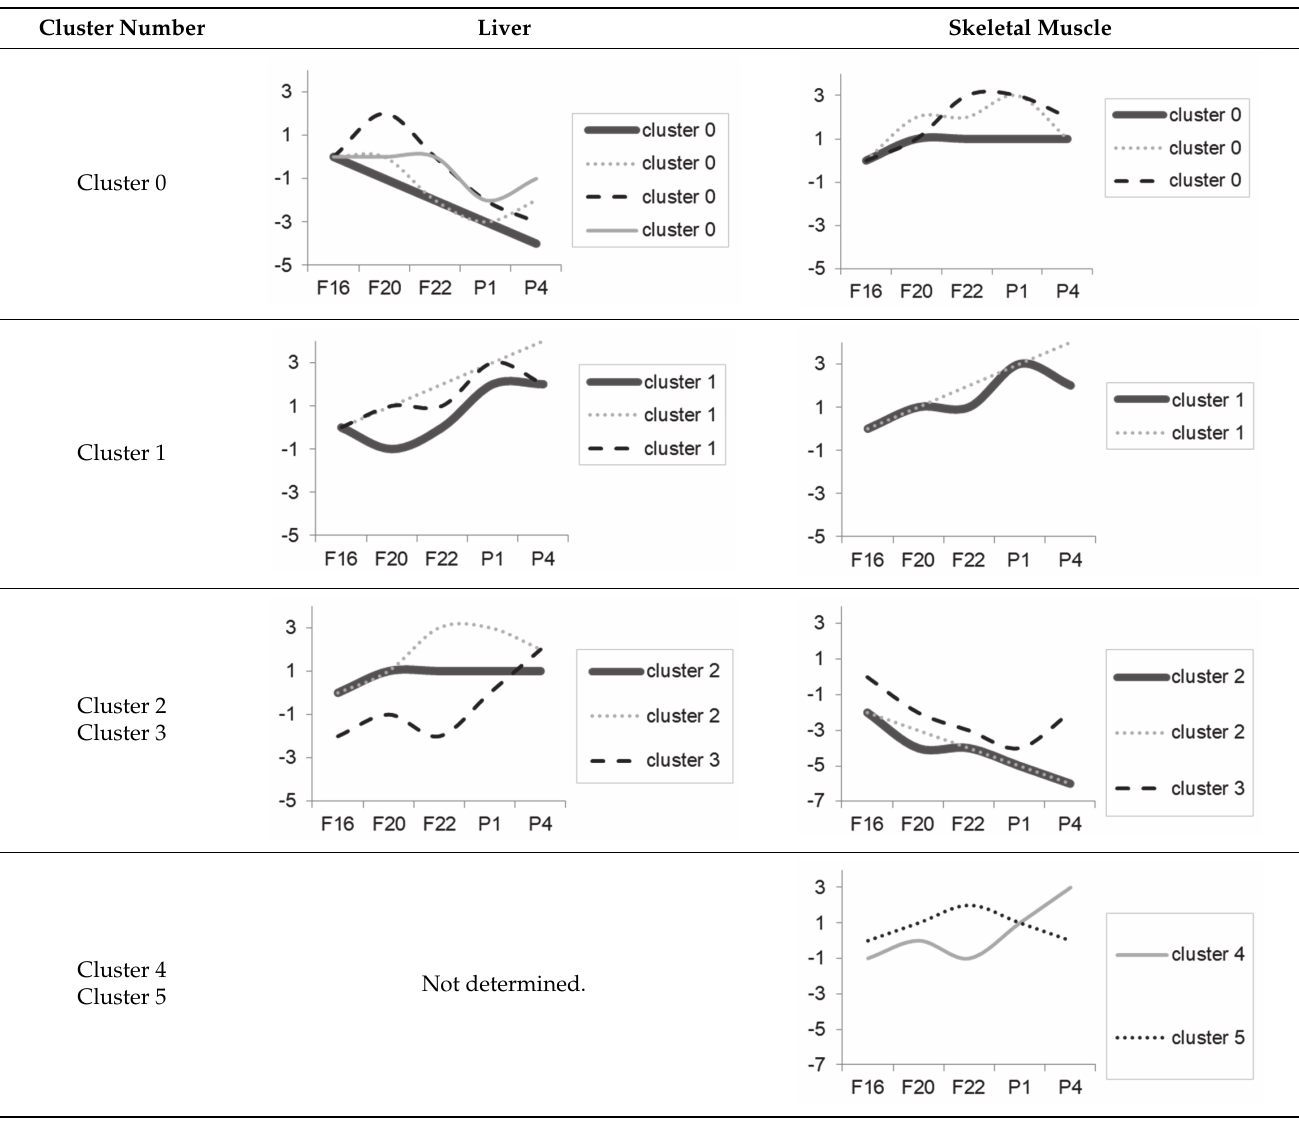
Table A1. STEM analysis of microarray data. STEM analysis defined 81 types of expression profiles. Each gene was aligned with certain expression profile. Clusters with more genes than expected were found to be significant ( p ≤ 0.05). In the liver, there were 4 clusters with a significantly enriched number of genes identified (Clusters 0–3). In skeletal muscle, there were six clusters identified (Clusters 0–5). Genes which were clustered by STEM are available in the Supplementary data files